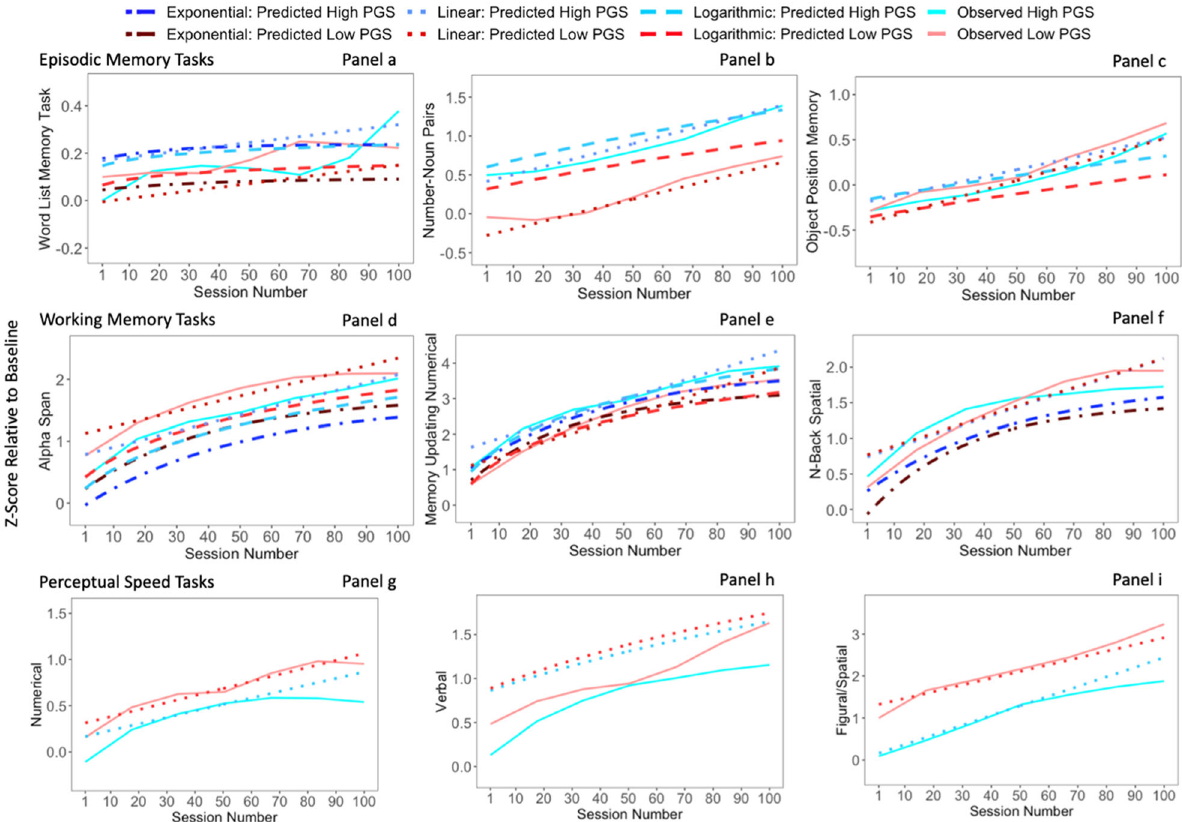
Fig. 5 Paneled plot of means in performance over the practice phase. Subgroup means are created by extreme PGS groups (i.e., 15 participants with the lowest EAPGS vs. 15 participants with the highest EAPGS) on all cognitive